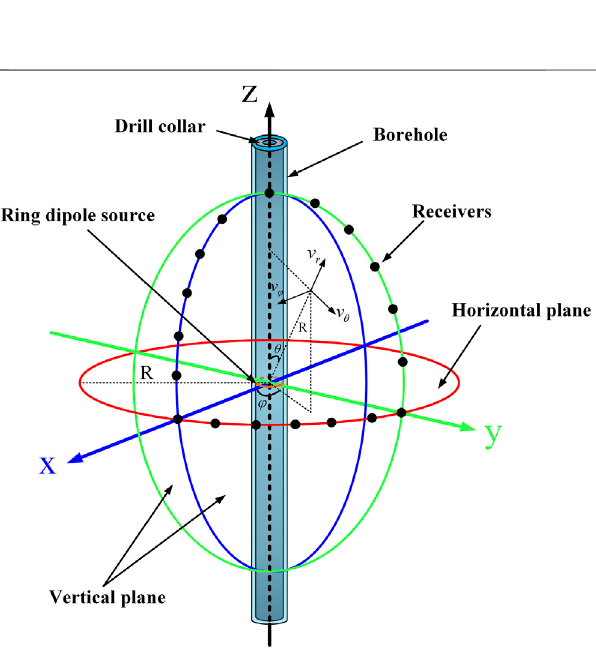
Figure 3 shows the snapshot of total vibration velocity in the xoy -plane at 3.1483 ms. The wave propagation pattern in the horizontal plane in LWD context is similar to the results associated with an open borehole. The snapshot reveals the propagation P- and SH-waves which have different dominant radiation directions (Tang et al., 2014). The amplitude of the